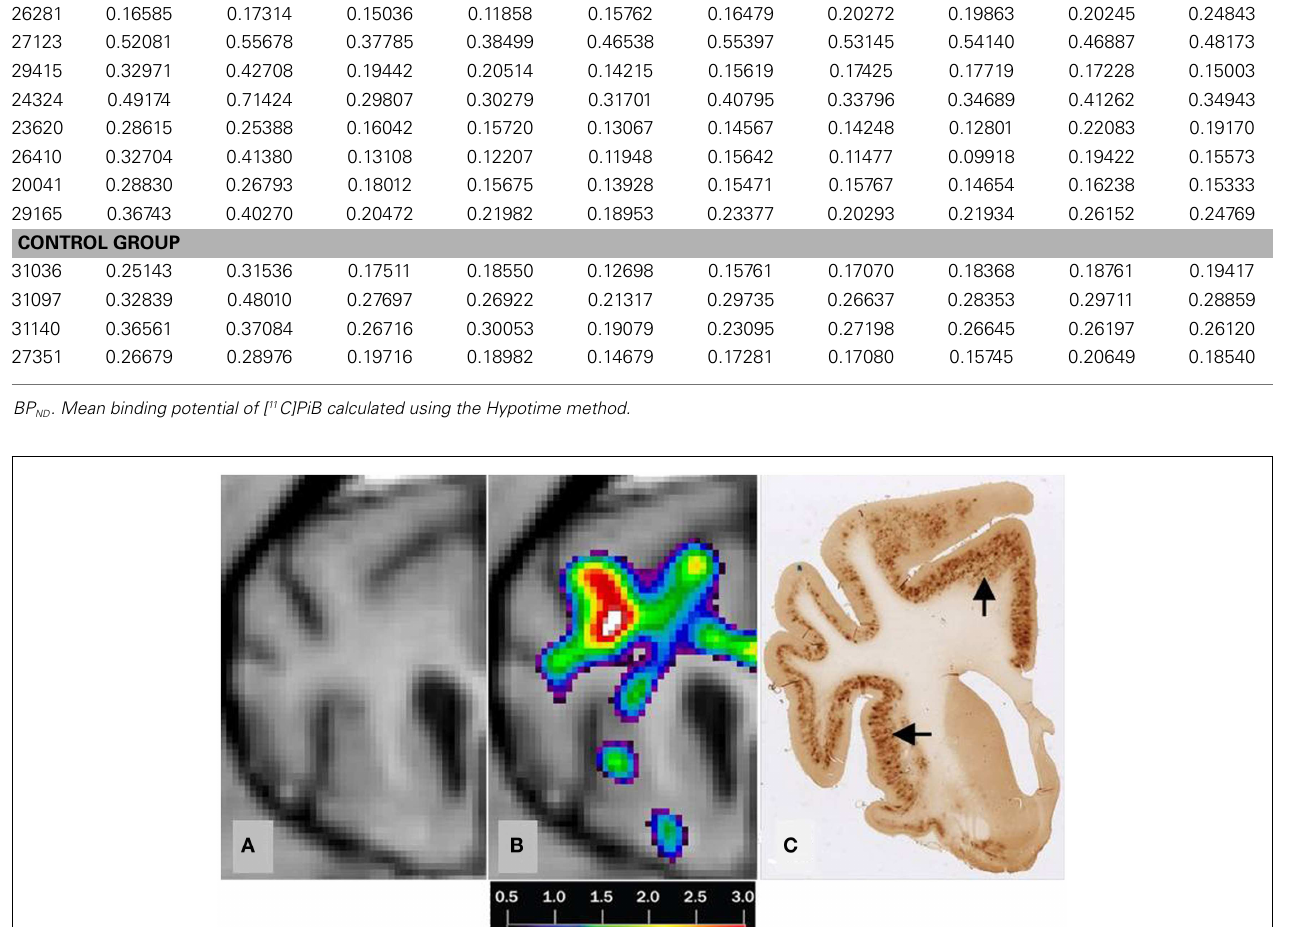
FIGURE 3 | Correlation of MRI [ 11 C]PiB PET imaging and histopathology of a transverse brain section at the level of the rostral commissure and the corpus striatum .The brain is from a 17-year old small mixed breed male dog with clinical diagnosis of CCD. (A) Transverse MRI of brain from CCD dog at the level of rostral commissure and the corpus striatum (B) MRI from picture 1 and corresponding [ 11 C]PiB PET imaging. [ 11 C]PiB binding is indicated by a color scale with red indicating